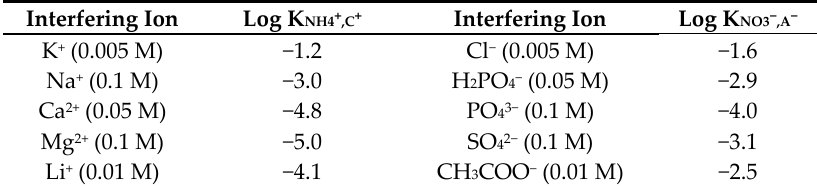
Table 1. Selectivity coefficients (log K ij ) obtained with the Fixed Interference Method for pNH 4 - and pNO 3 -ISFET. The constant concentration of interfering ion is indicated in